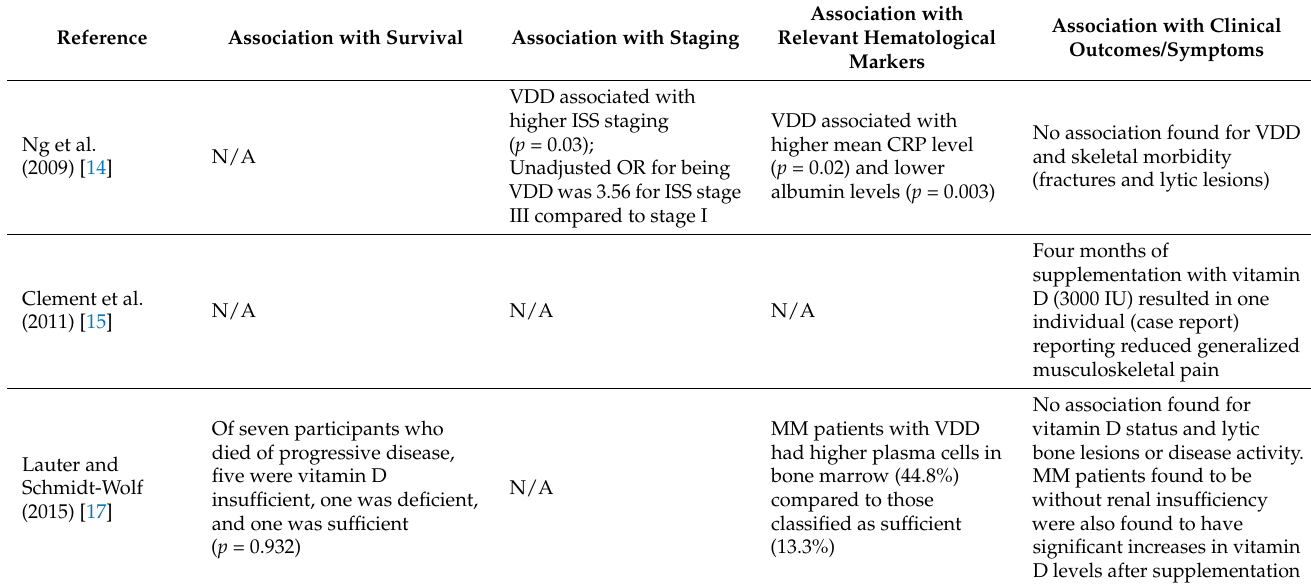
Table 4. Vitamin D deficiency (VDD) and MM prognosis, clinical outcomes, and disease